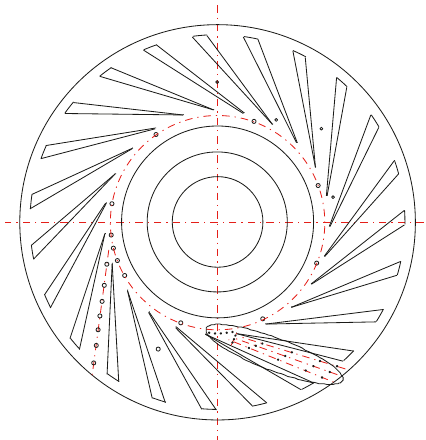
Figure 3: Steady and unsteady pressure taps in the